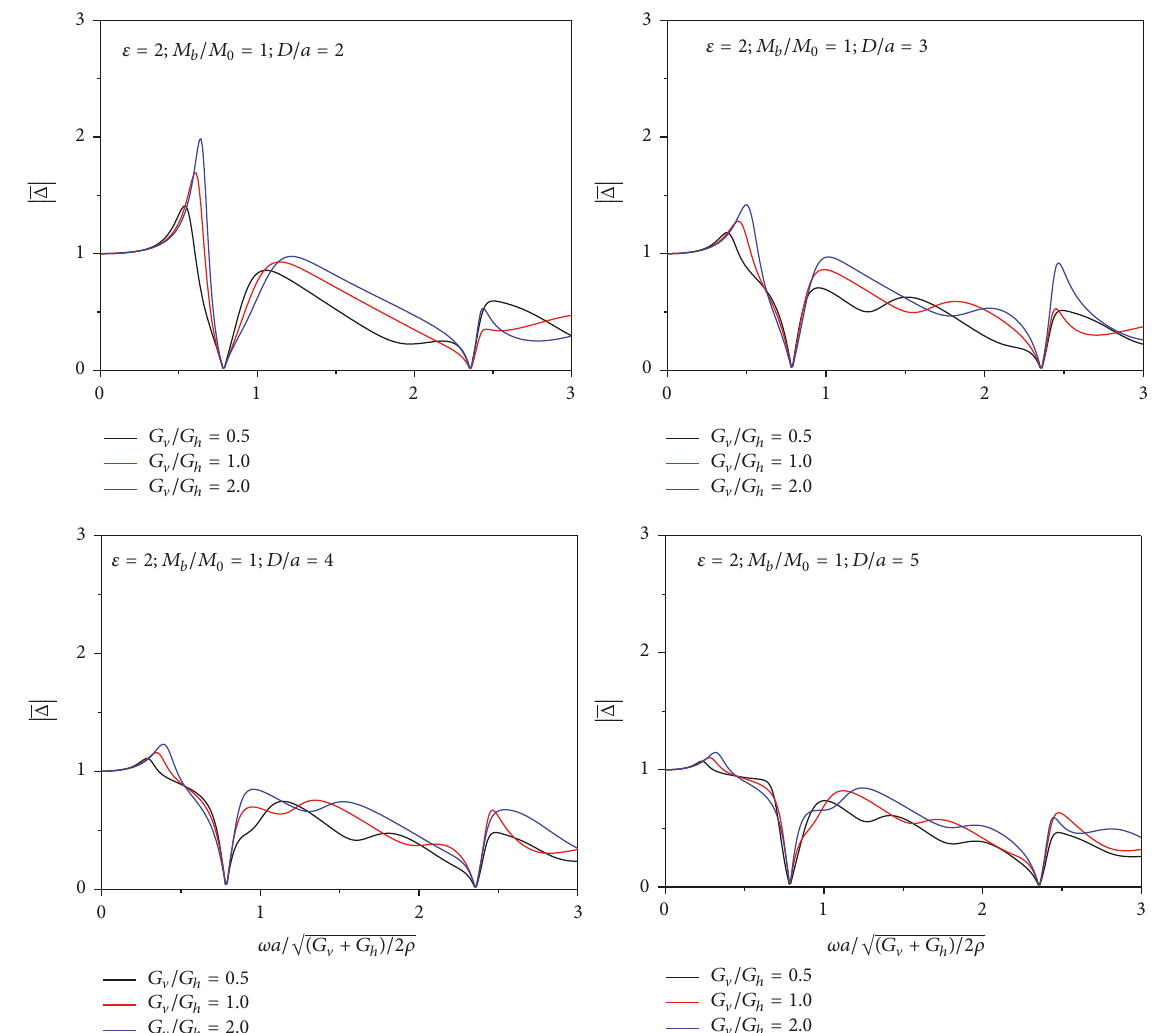
Figure 5: The effective input motion for different thicknesses of soil